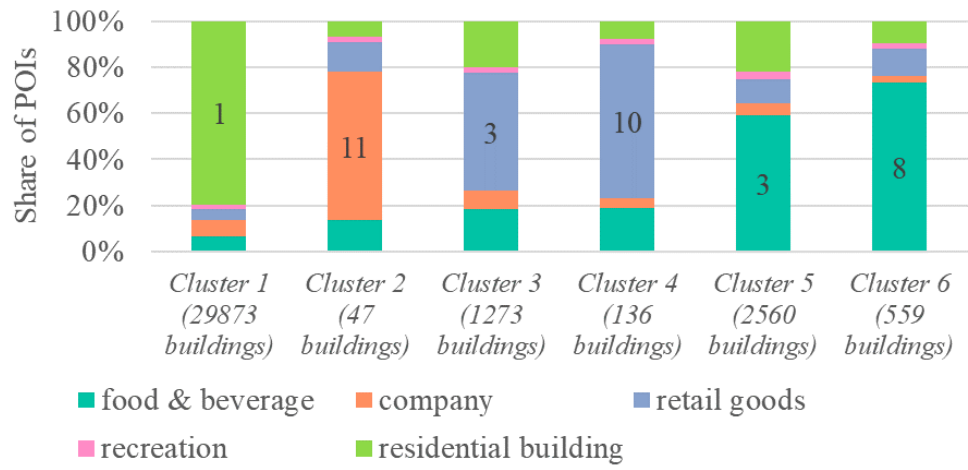
Figure 5. Residential sub-type clustering.